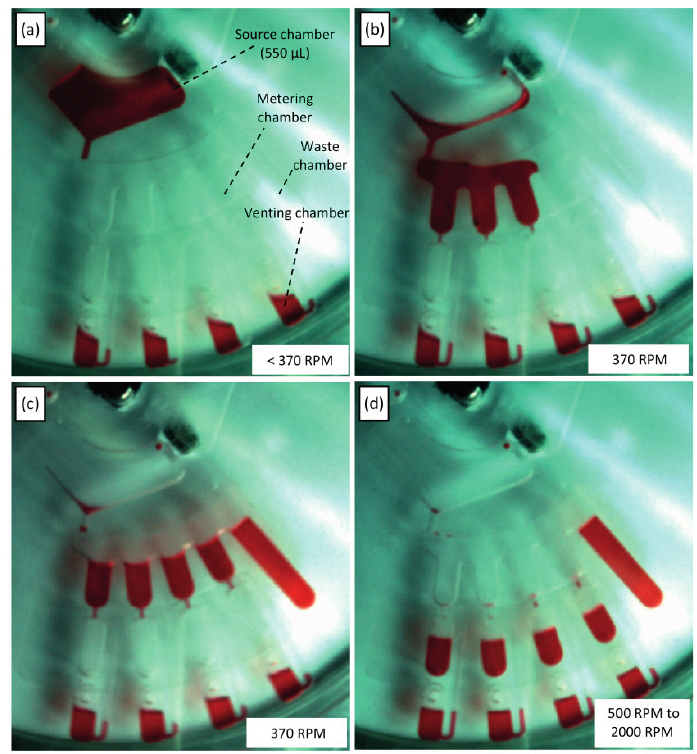
Figure 7. Photos of liquid metering at various stages of the process, ( a ) spinning speed less than 370 RPM, ( b ) & ( c ) the metering chambers are filled whereas the extra liquid overflowed to the waste chamber at 370 RPM, and ( d ) liquid transferred from the metering chamber towards the destination chambers (500 RPM to 2000